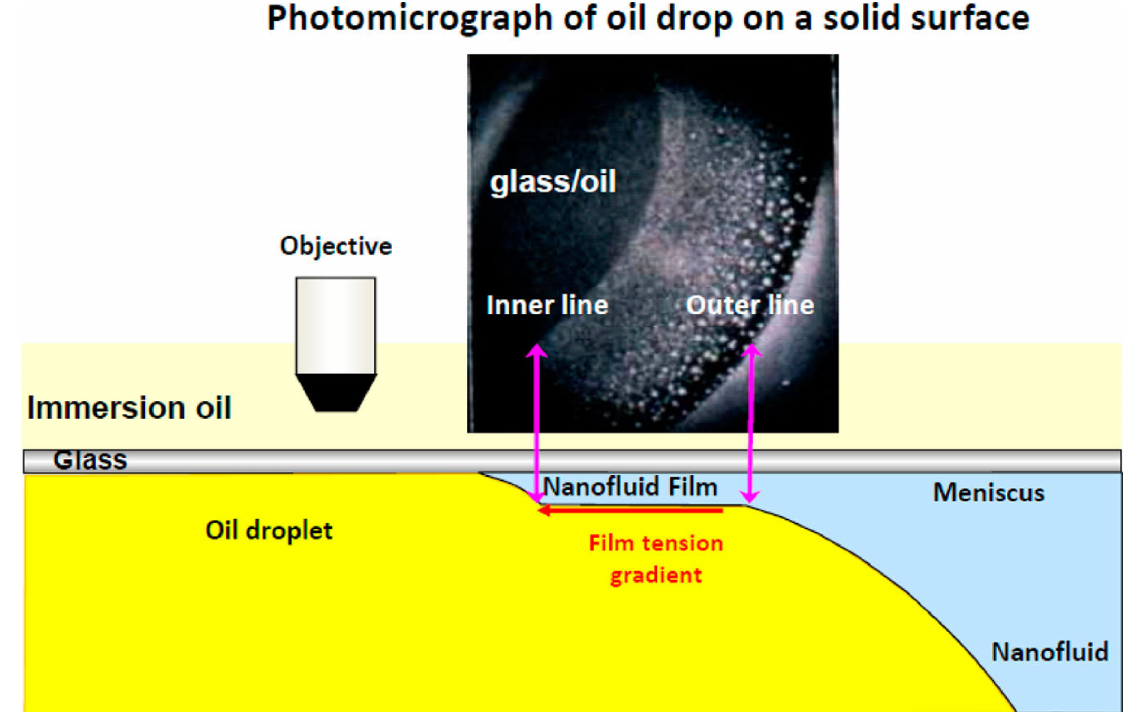
Figure 10. Scheme and photomicrograph depicting inner and outer contact lines and the nanofluid film region. Figure reproduced from Ref. [86].